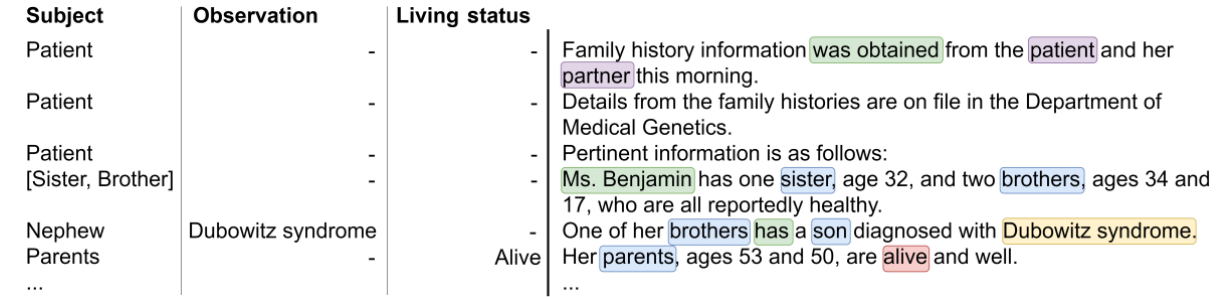
Figure 2. The 3 left concepts represent the main points that the system tries to identify in the text on the right. Highlighted on the right are relevant words for the system to be able to make decisions. Auxiliary words that help identify the subject are represented in green. The words used to identify if the relatives are related to the patient or the partner are highlighted in purple. Blue represents annotated family members, and yellow is used for diseases. Red is used to highlight words concerning subject living status.